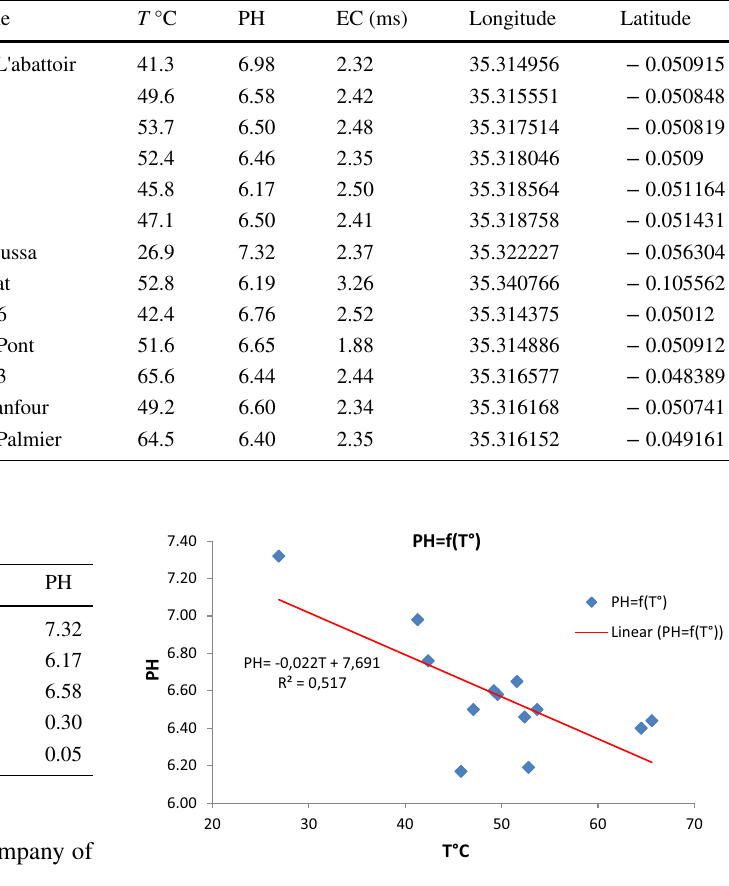
Table 1 Field measured